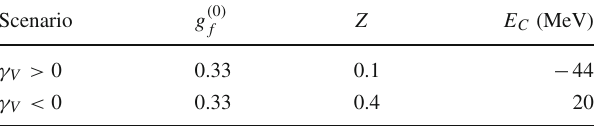
Table 6 The value of the coupling g f when the physical pole location is reached by one of the three poles of the scattering matrix and the corresponding values taken by the Weinberg Z -factor and the zero of the scattering amplitude E C for both scenaria ( γ V > 0 and γ V < 0)